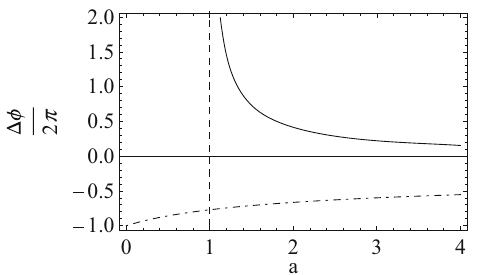
Fig. 12 Behaviour of the function (61) in dependence on the rotational parameter a , depicted as the full curve, which represents the shift of nodes (cid:4)φ oforbitswithzeroenergy.Thedot-dashedcurveisadepiction of the lowest negative shift of nodes of a retrogressive spherical orbits approachingthepositionoftheequatorialcircularcounter-rotatingorbit at r = r ph − . It can be seen that the increase of the rotational parameter a weakens the negative shift due to strong dragging of the spacetime. The shift is always (cid:4)φ > − 2 π